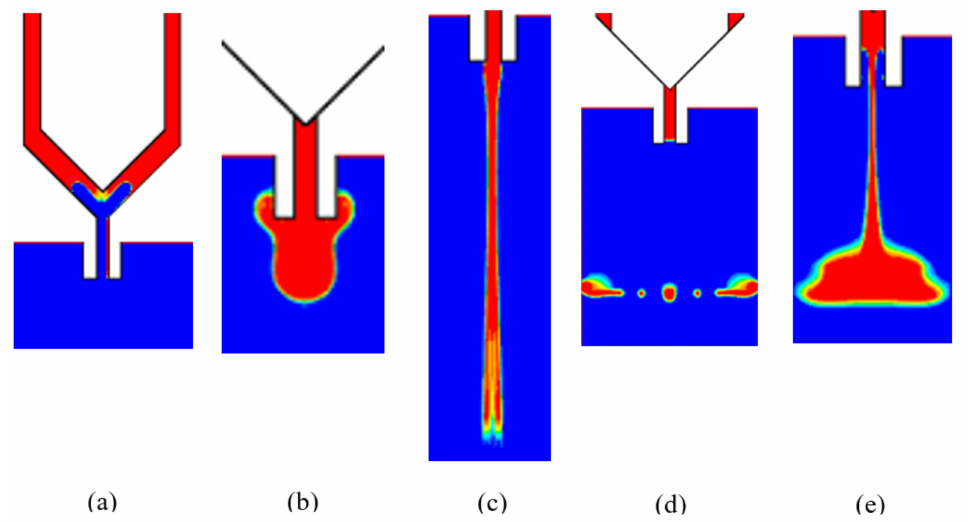
Figure 4. Dispense failure situation: ( a ) excessive back suction; ( b ) adhesion; ( c ) flow-stream; ( d ) satellite droplets; ( e )